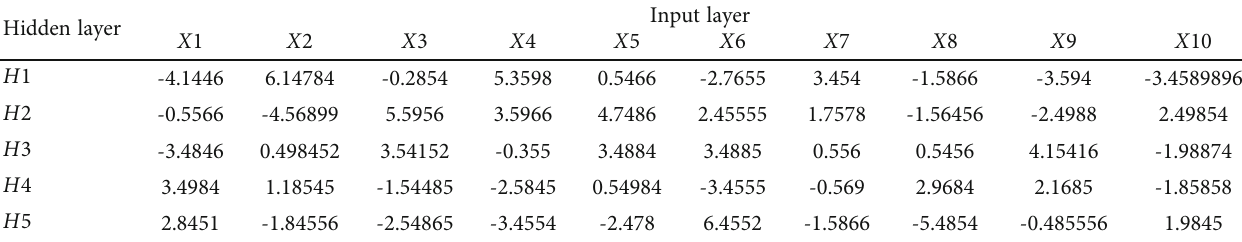
Table 1: Weights between the input layer unit node and the hidden layer unit node. Hidden layer